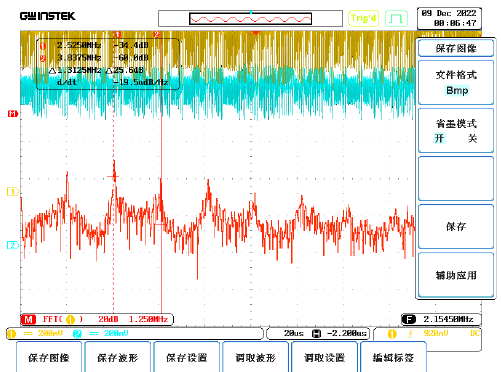
Figure 17. The photo of experimental circuit in operation.